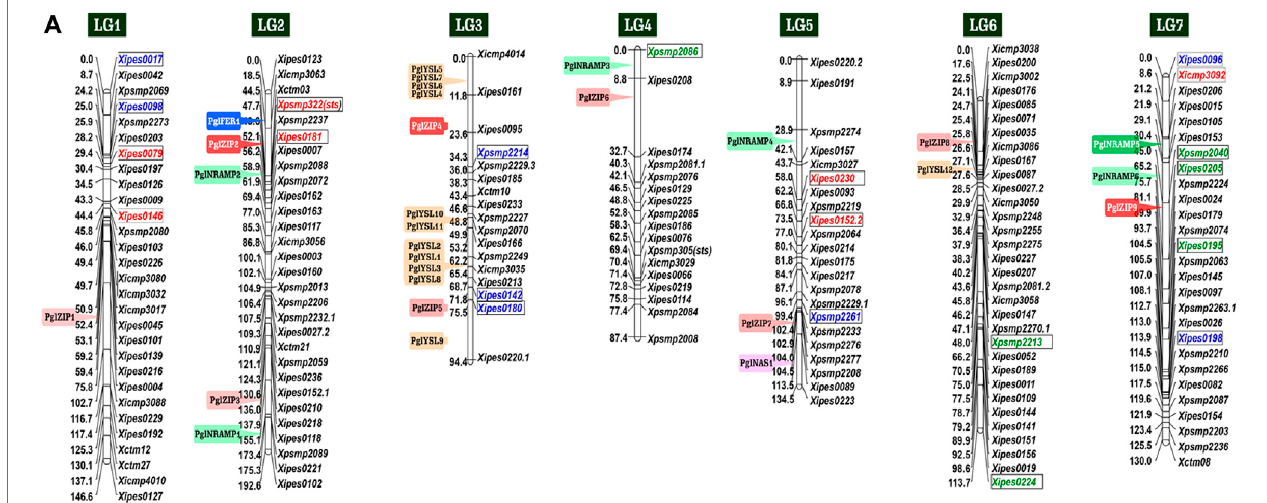
FIGURE 1 | List of the reported linked markers for QTLs, alleles and candidate genes for high grain Fe and Zn content in pearl millet on the consensus map of Rajaram et al. (2013) Note : Red font color indicates favorable allele for grain Fe content, green for grain Zn content and blue for both grain Fe and Zn content. The 29 genesforgrainFeand Znhomeostasisbelongingto fi vebroadfamiliesareinsolidcolorboxes.The fi vecandidate genesforgrainFeand Znareinsolidboxeswithwhite font (Data source: Mahendrakar et al., 2020).